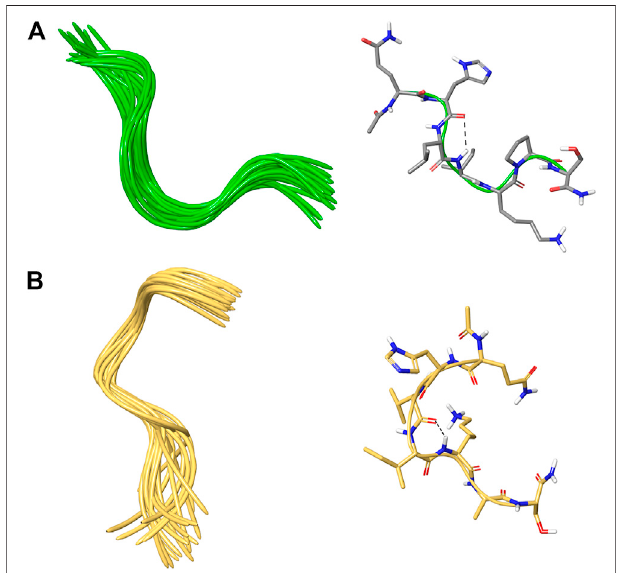
FIGURE 7 | (A,B) On the left, superposition of backbone atoms of 20 NMR structures of 1 (green ribbons) and 3 (faded orange ribbons) generated by using CYANA 2.1. (A,B) On the right, the average NMR derived structures of 1 and 3 .TheatomsaredepictedintubeandcoloredbyatomtypesC, grey for 1 ; C, faded orange for 3 ; O, red; N, blue; polar hydrogen, white. The dashed lines indicate intramolecular H-bonds responsible of the global